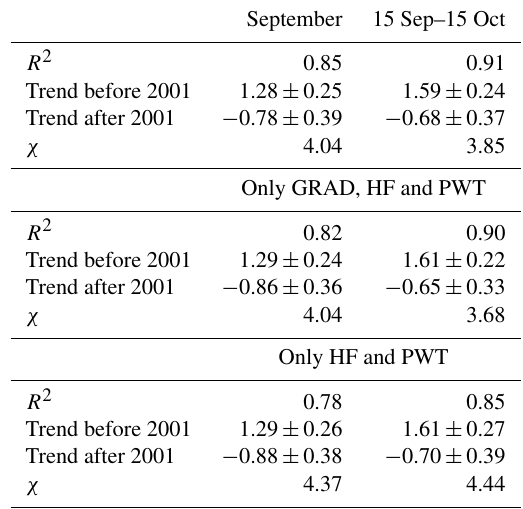
Table 4. Coefficient of determination R 2 and trends ± 2 σ in Mtyr − 1 before and after the turnaround year 2001 derived from multi-regression model using OMD dataset (MSR-2 total ozone columns and threshold of 220DU; see the text) for September and 15 September–15 October over 1980–2017 period. The residual is represented in Mt by χ as explained in Table 2.